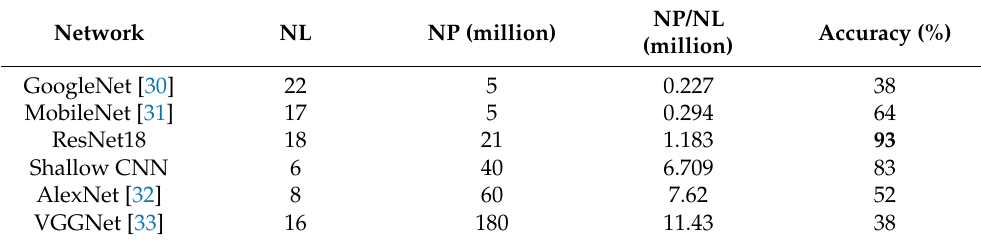
Table 1. Model parameters and their